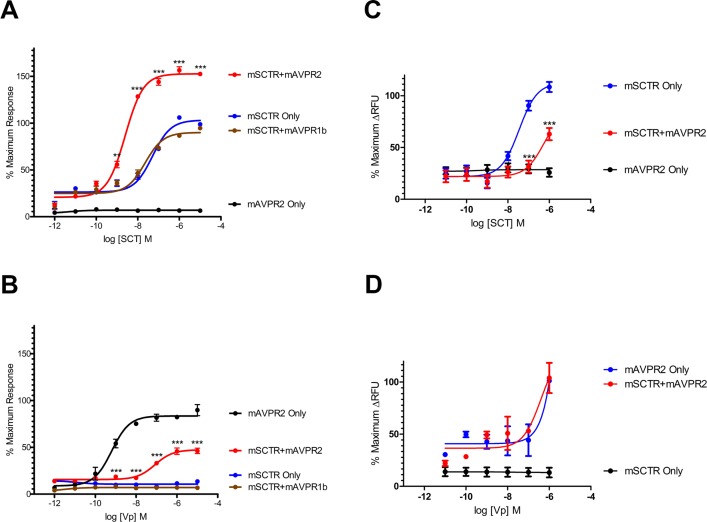
Signaling modification as a specific consequence of SCTR-AVPR2 oligomerization.Percentage changes in maximum cellular cAMP levels when cells were expressing a combination of mSCTR and/or mAVPR constructs, comparing to cAMP responses in cells bearing only the native receptor to the ligand. A) SCT stimulated a marked shift in Emax and potency in mSCTR in the presence of mAVPR2. No significant changes were observed when the non-interacting mAVPR1b replaced mAVPR2. B) Similarly, Vp stimulated a notable reduction in Emax and potency in mAVPR2 in the presence of mSCTR. The data were mean±SEM from three to five independent experiments in triplicate. ***, P<0.001. **, P<0.01. *, P<0.05. 10pM to 1μM SCT (panel C) or Vp (panel D) were treated to cells with mSCTR and/or mAVPR2. Calcium response curves are presented as percentages of maximal changes in RFU of cells expressing mSCTR or mAVPR2 only and stimulated with 1μM peptide. Except for cells with mSCTR only, a marked increase in cellular calcium response can only be seen at 1μM peptide concentration. Data were obtained from three individual experiments with 5–6 ROIs per dose.